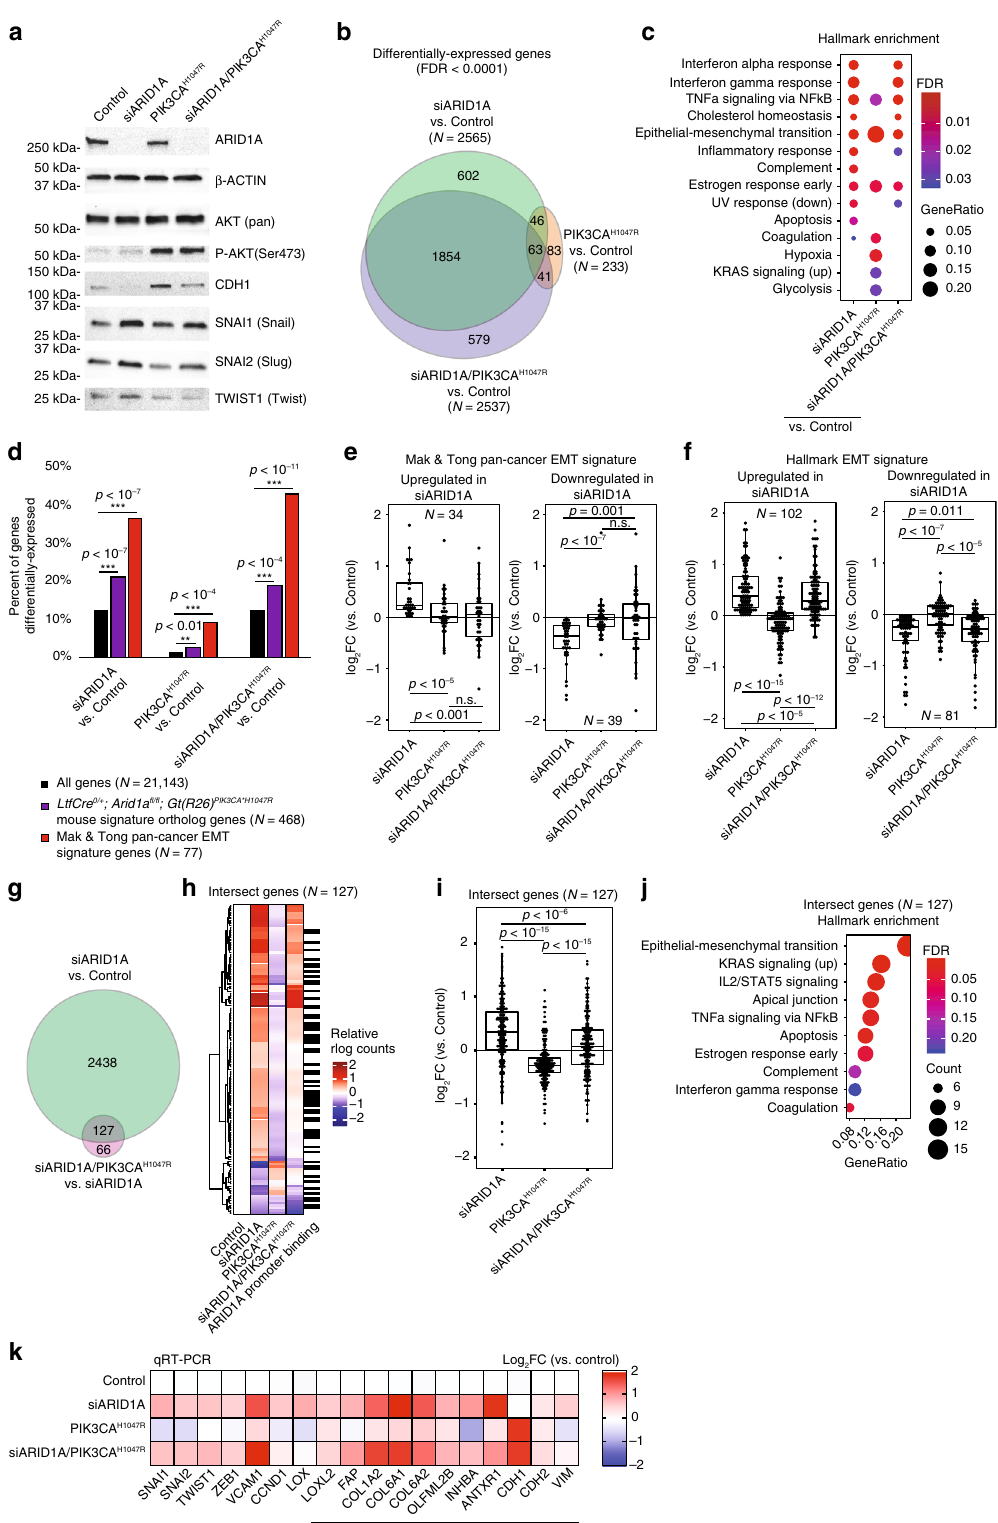
ARID1A loss and PIK3CA H1047R promote invasive pheno- (Fig. 6j). The differential gene expression of EMT genes upon types . Partial EMT is associated with invasive phenotypes 38 , and ARID1A loss was con fi rmed by quantitative reverse transcrip- tase (qRT)-PCR (Fig. 6k). These data provide further evidence EMT pathways play key roles in EC disease progression by pro- that ARID1A loss induces a mesenchymal phenotype, which is moting the invasion of epithelial cells into the myometrium 44 . To antagonized by the PIK3CA H1047R mutation, resulting in a distinguish between the effect of ARID1A loss or PIK3CA H1047R partial EMT phenotype. on invasive phenotypes, we co-transfected 12Z cells with a NATURE COMMUNICATIONS| (2019) 10:3554